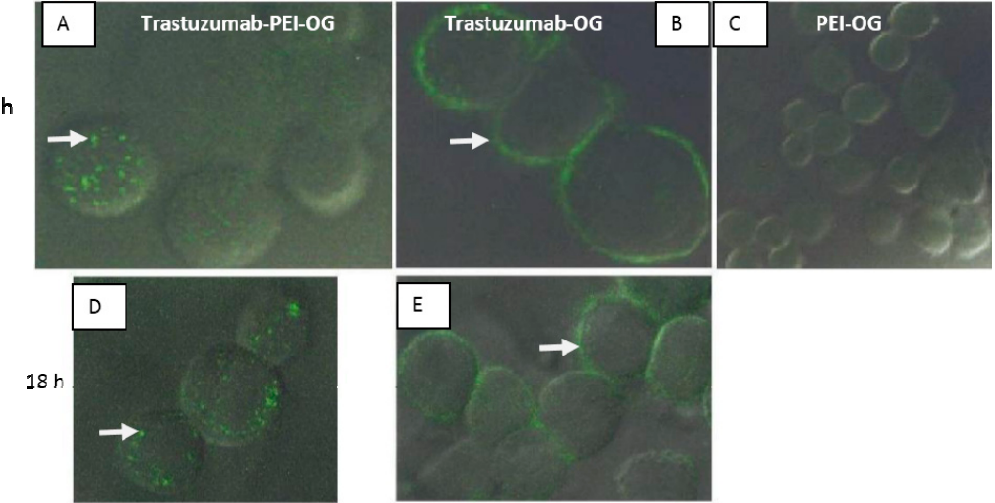
Figure 3. Confocal microscope images of SKBr3 cells incubated for 2 and 18 h with ( A , D ) Trastuzumab-PEI-OG, ( B , E ) Trastuzumab-OG, and ( C ) PEI-OG. The Trastuzumab-PEI-OG was visible inside the cell ( A and D arrows), and Trastuzumab-OG was visible around the cells ( B and E arrows).